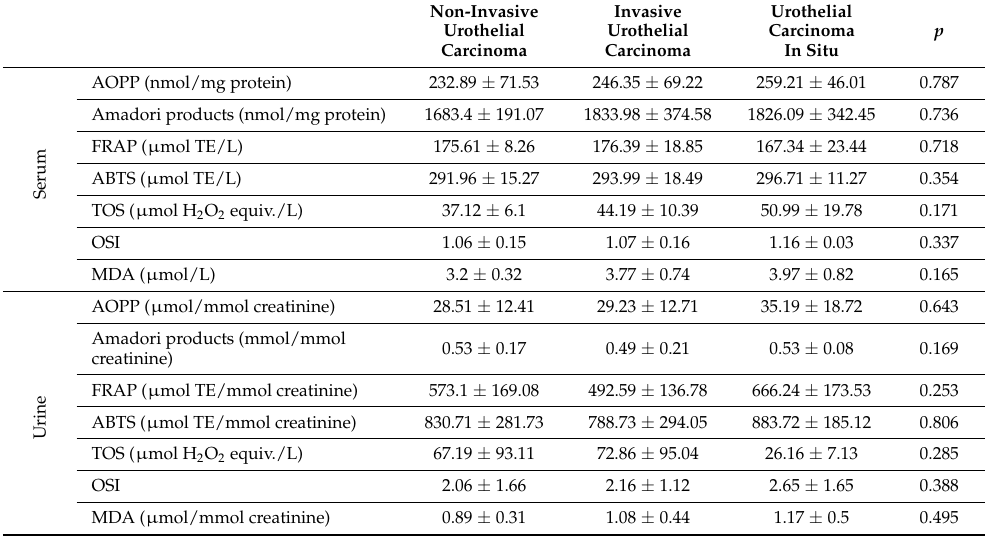
Table 2. Markers of oxidative stress in participants with bladder cancer depending on type of cancer *.